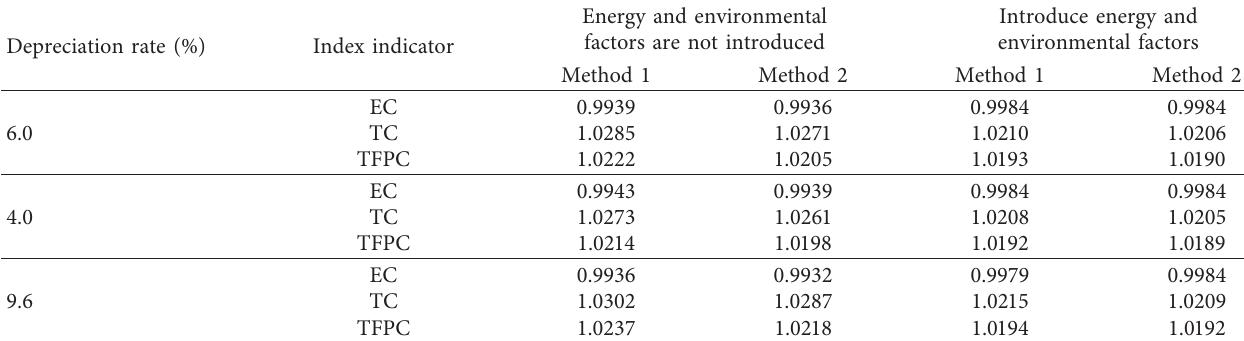
Table 6: Robustness tests of two kinds of TFP index measurement